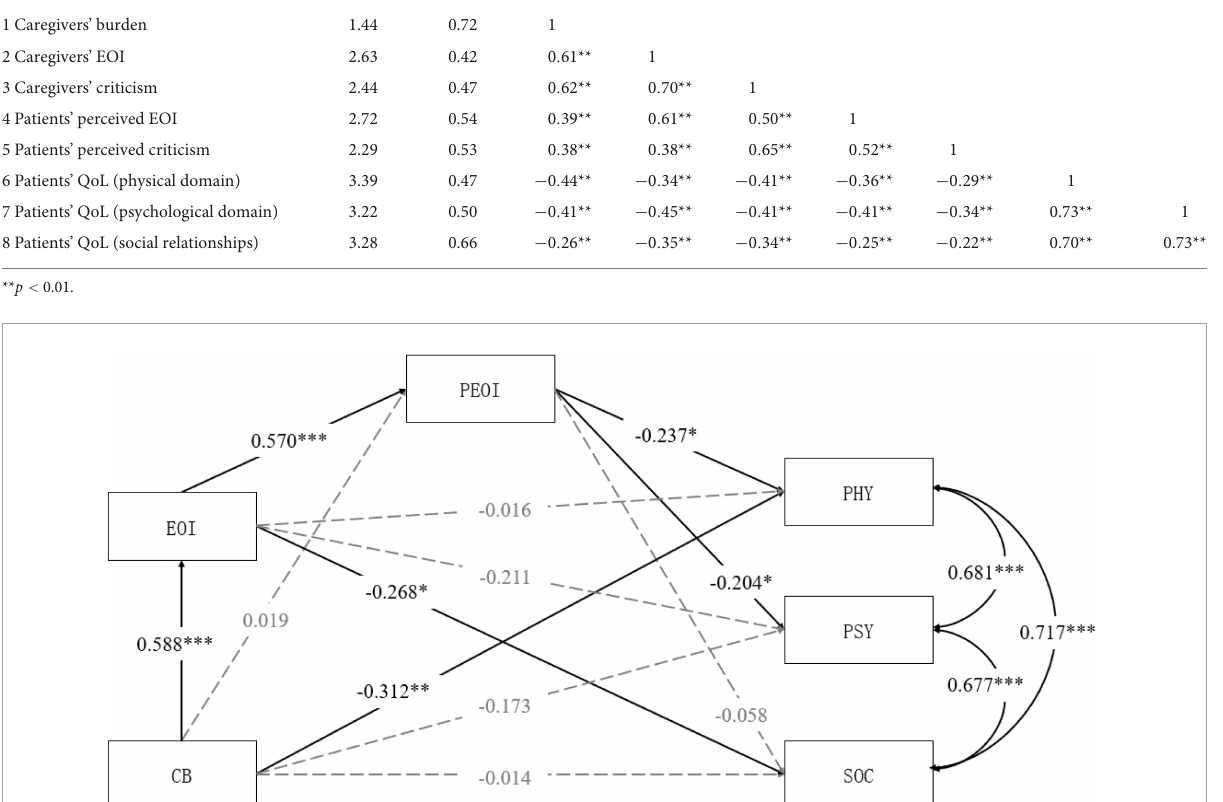
FIGURE2 The mediating model of EOI and PEOI between CB and QoL (PHY, PSY, and SOC). CB, care burden; EOI, caregivers’ emotional over-involvement; PEOI, patients’ perceived emotional over-involvement; PSY, psychological domain of patients’ QoL; SOC, social